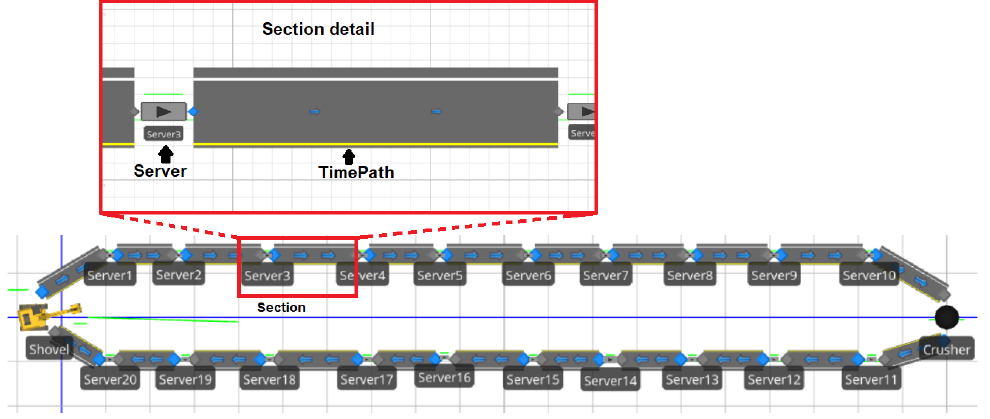
Figure 3. Illustration of the conceptual proposal.